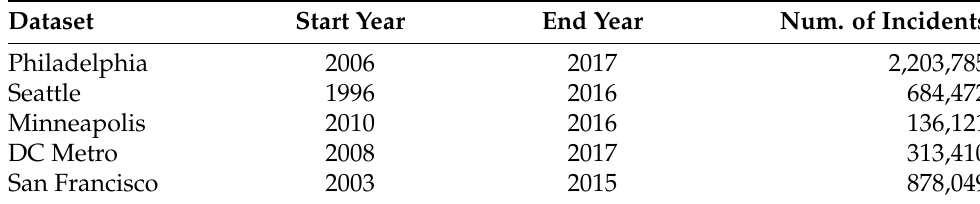
Table 2. Basic statistics for the 5 examined